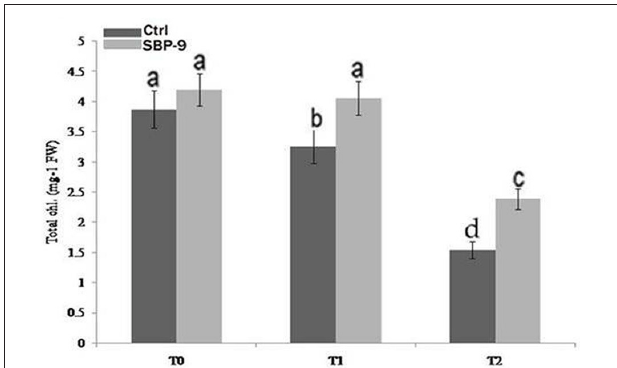
FIGURE 3 | Effect of inoculation of isolate SBP-9 on total chlorophyll content under different treatments (T-0, T-1, T-2). Significant difference in each column has been shown by different